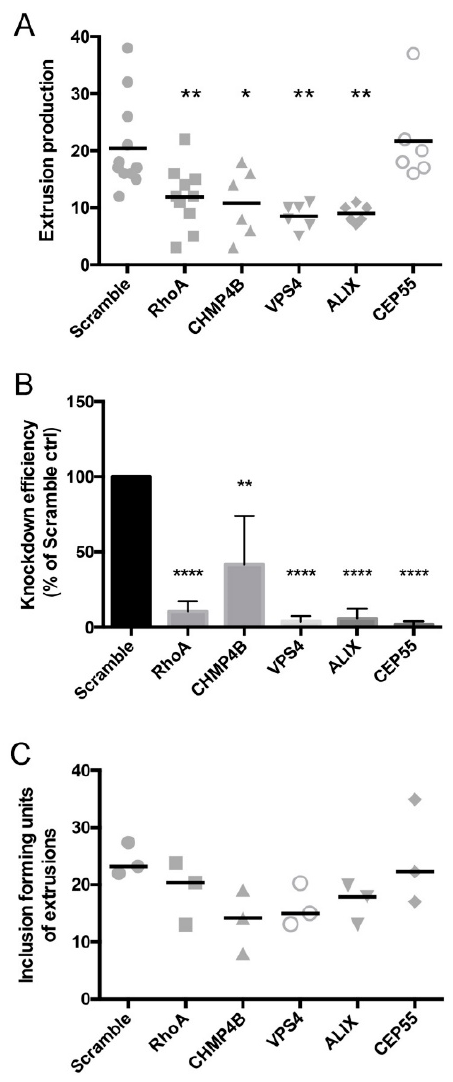
Figure 5. Chlamydia extrusion release is dependent on host abscission proteins. ( A ) The release of C. trachomatis containing extrusions from siRNA-treated HeLa cells was determined measured by microscopic analysis of centrifugation-enriched extrusion suspensions. ( B ) Knockdown efficiencies of siRNA treatments on Chlamydia -infected HeLa cells, as measured by quantitative RT-PCR. ( C ) IFU determinations on isolated extrusion suspensions were performed by plating sonicated extrusion samples onto fresh HeLa cells, followed by IFU analysis at 48 hpi. Data points show mean ± SEM, n = 3. Statistics were performed using One-Way ANOVA with Dunnett’s multiple comparisons post-test. **** denotes p value < 0.0001, ** denotes p value < 0.01, * denotes p value < 0.05.